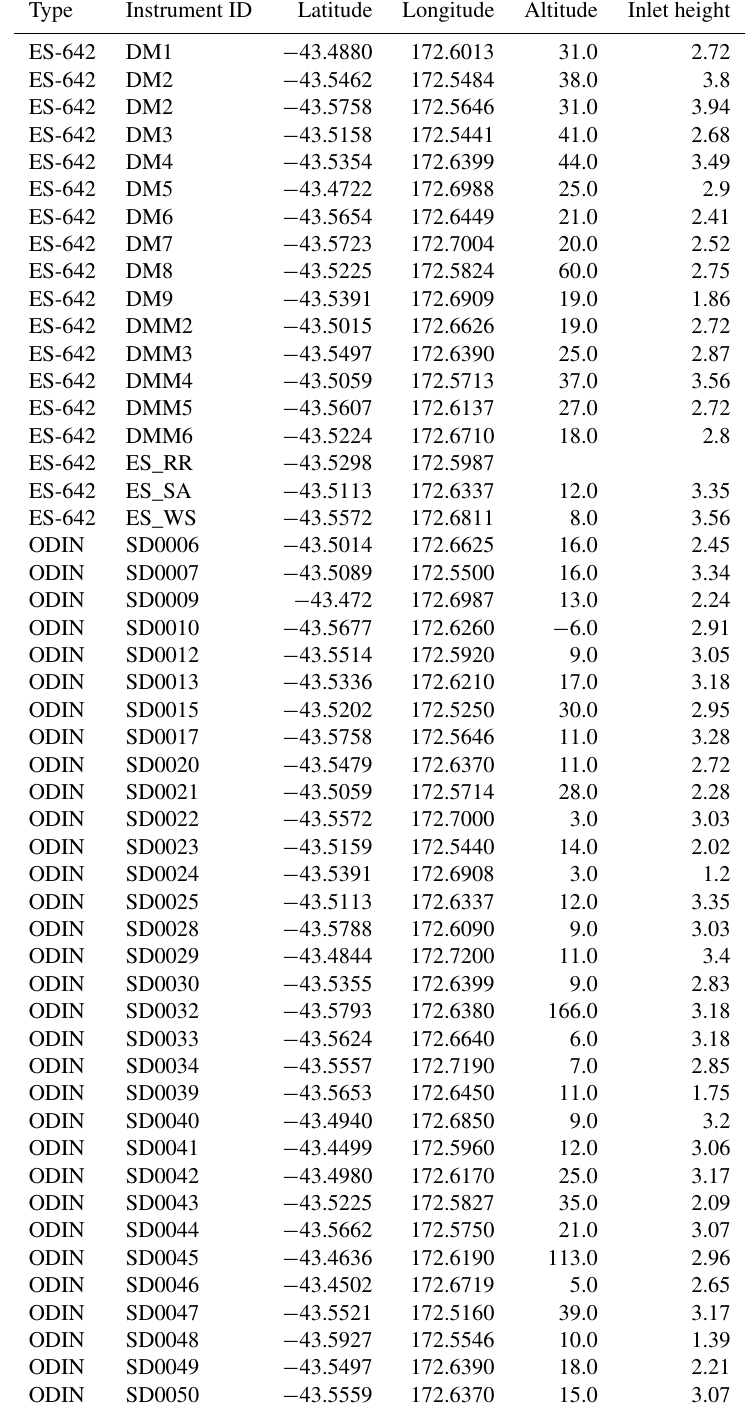
Table B1. The IDs and locations of the PM sensors and AWSs installed during the